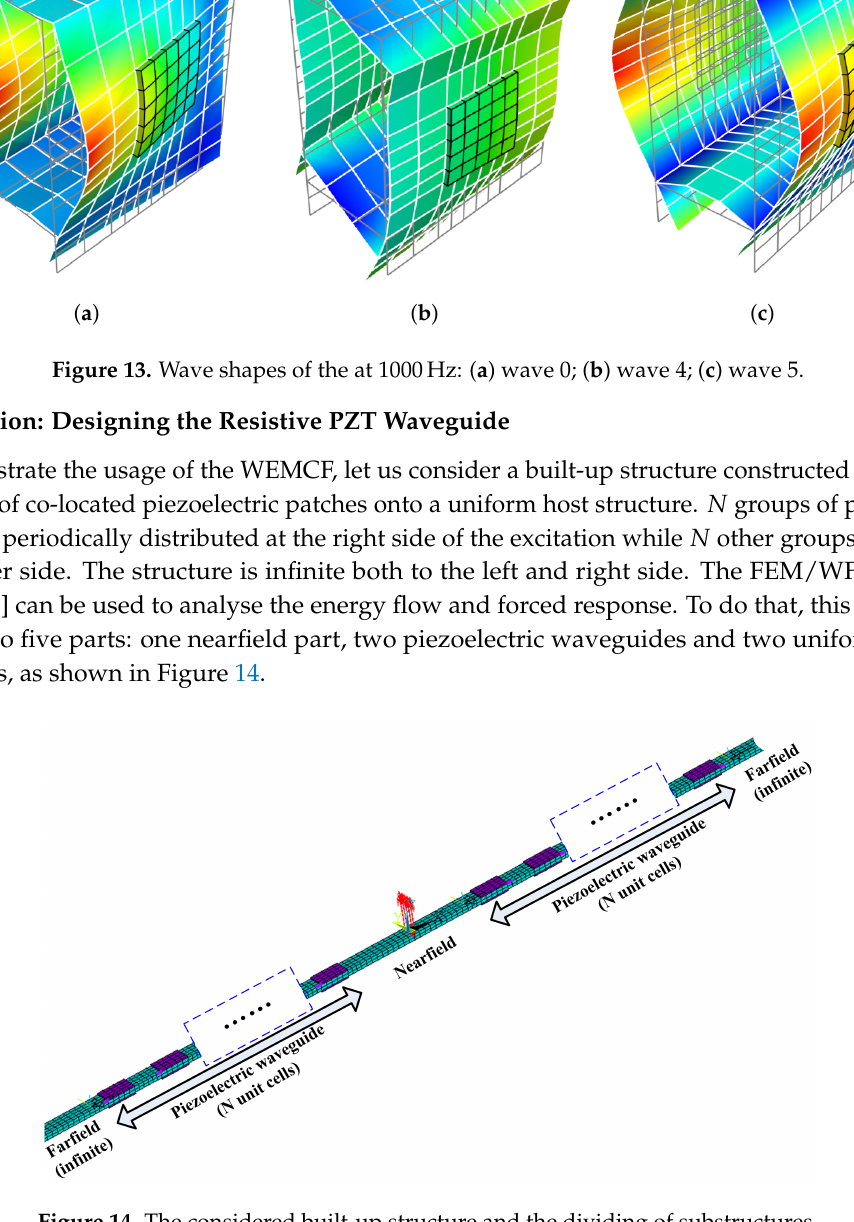
Figure 14. The considered built-up structure and the dividing of